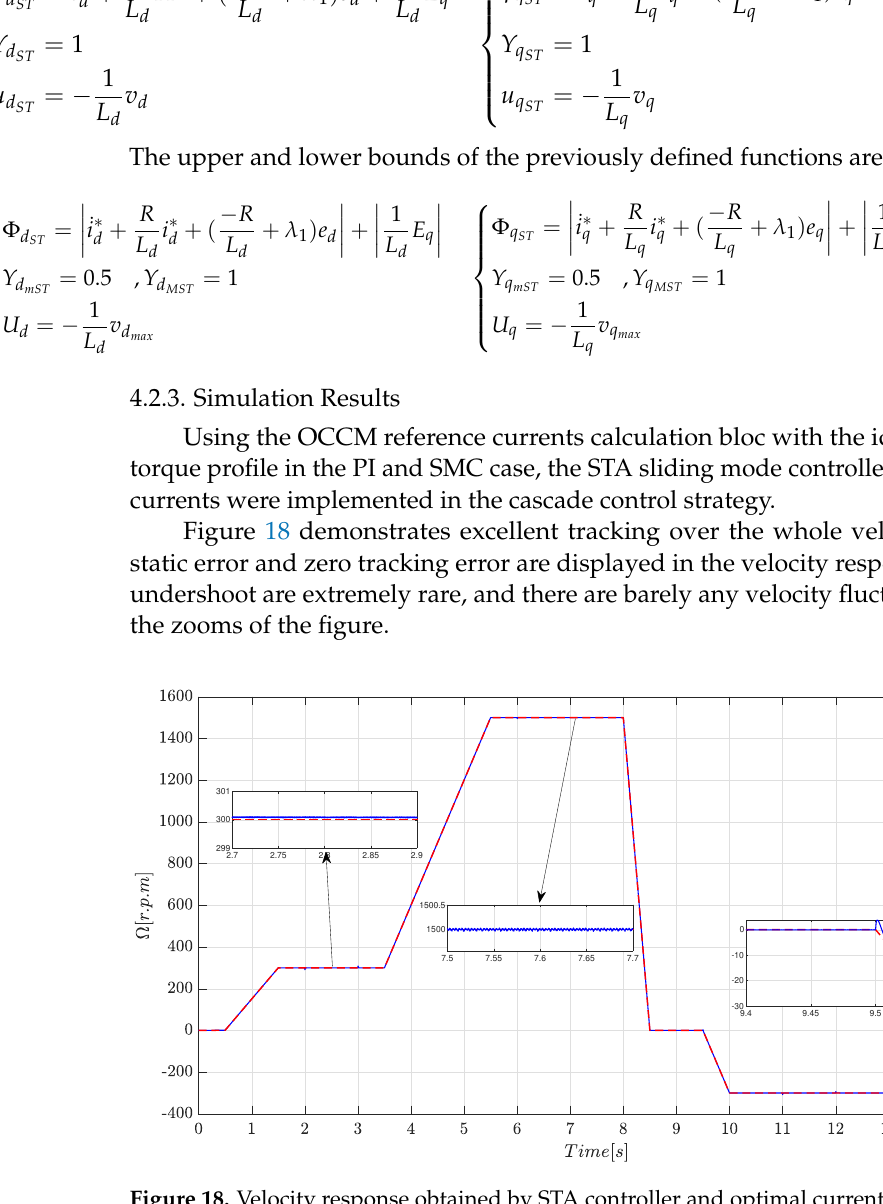
Figure 18. Velocity response obtained by STA controller and optimal currents calculations